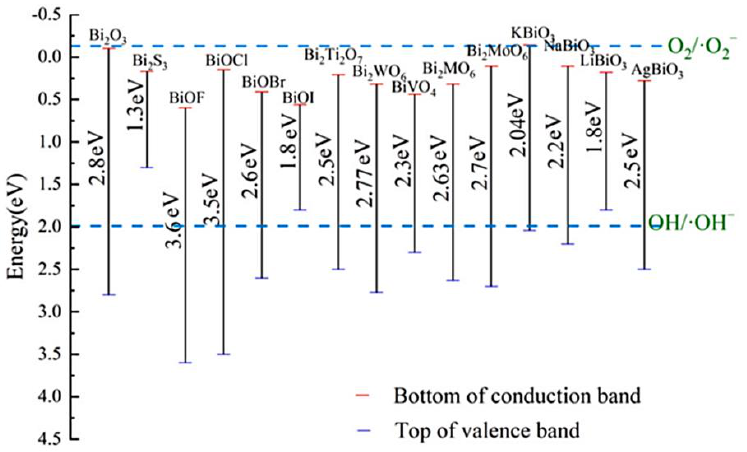
Figure 2. The band edge positions of bismuth-based photocatalysts. Almost all the tops of the valence bands of bismuth-based photocatalysts are higher than the redox potential of • OH/OH − (+1.99 eV). Reproduced with permission from [45]. Copyright 2021 Elsevier.